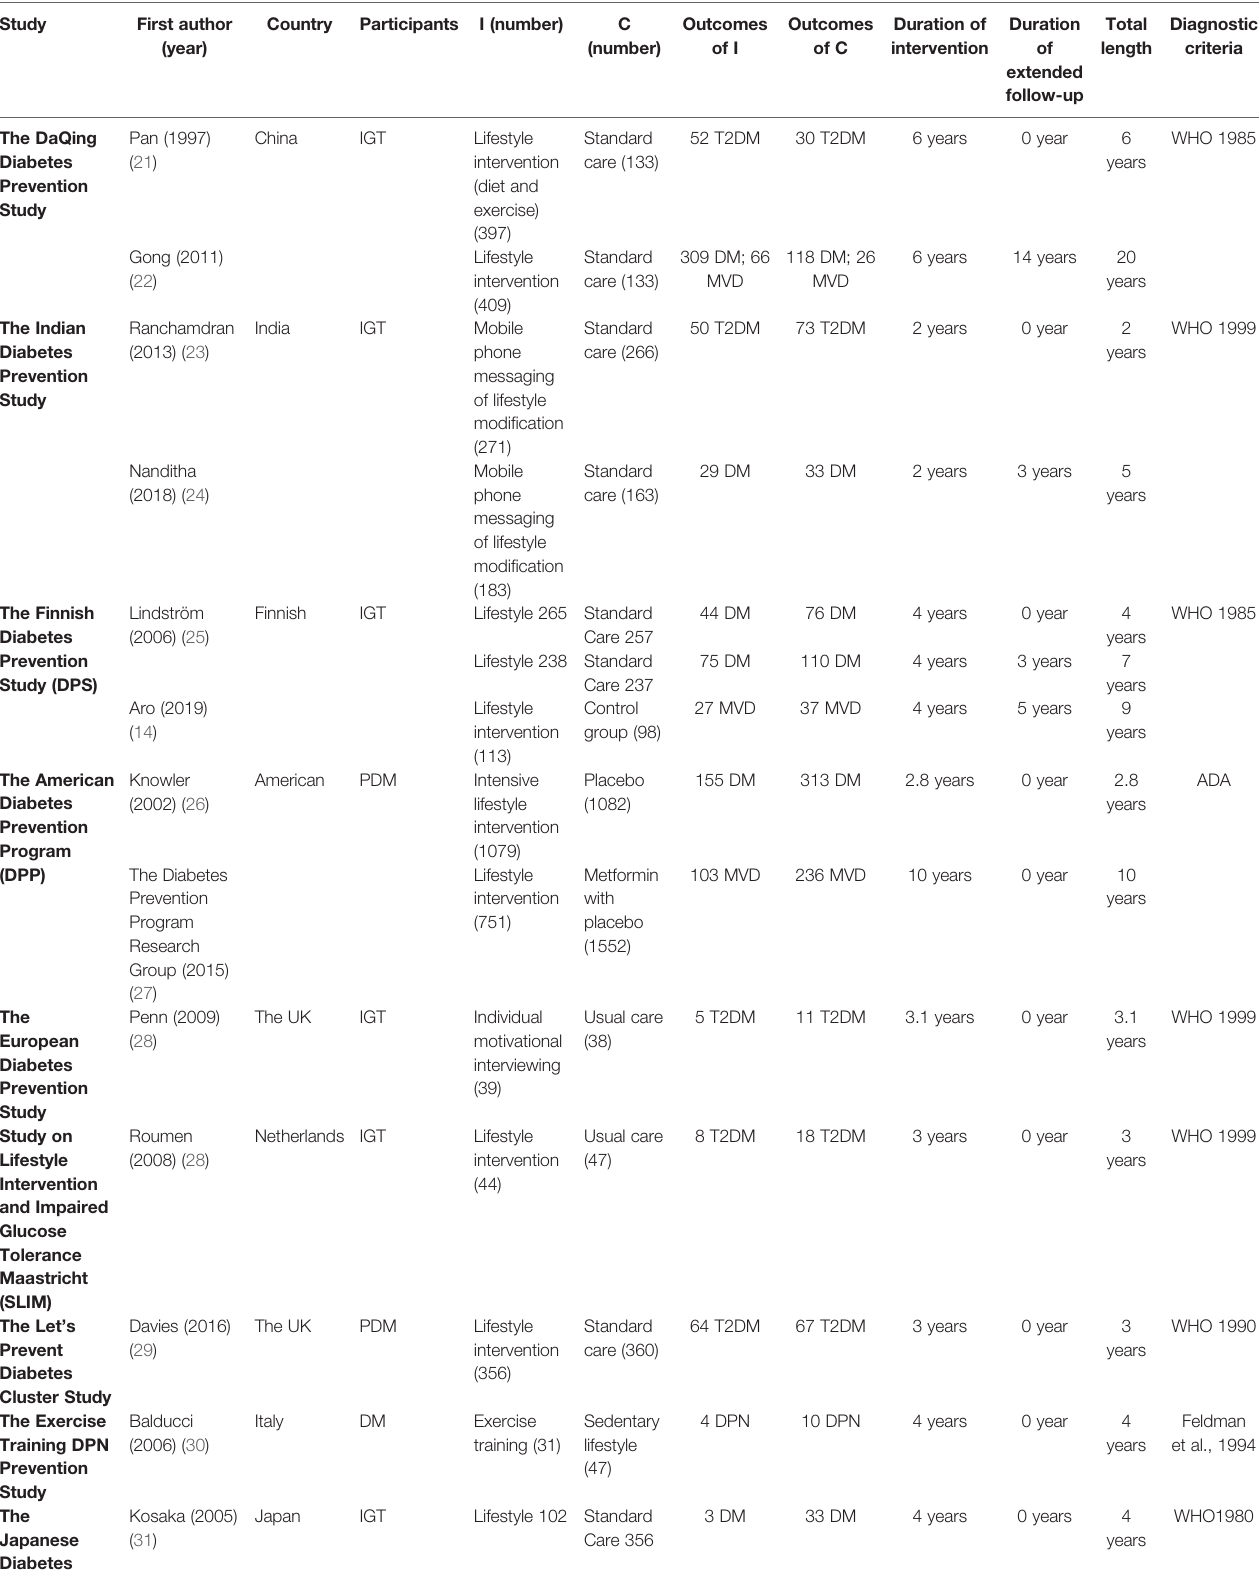
TABLE 1 | The main characteristics of eligible articles included in the